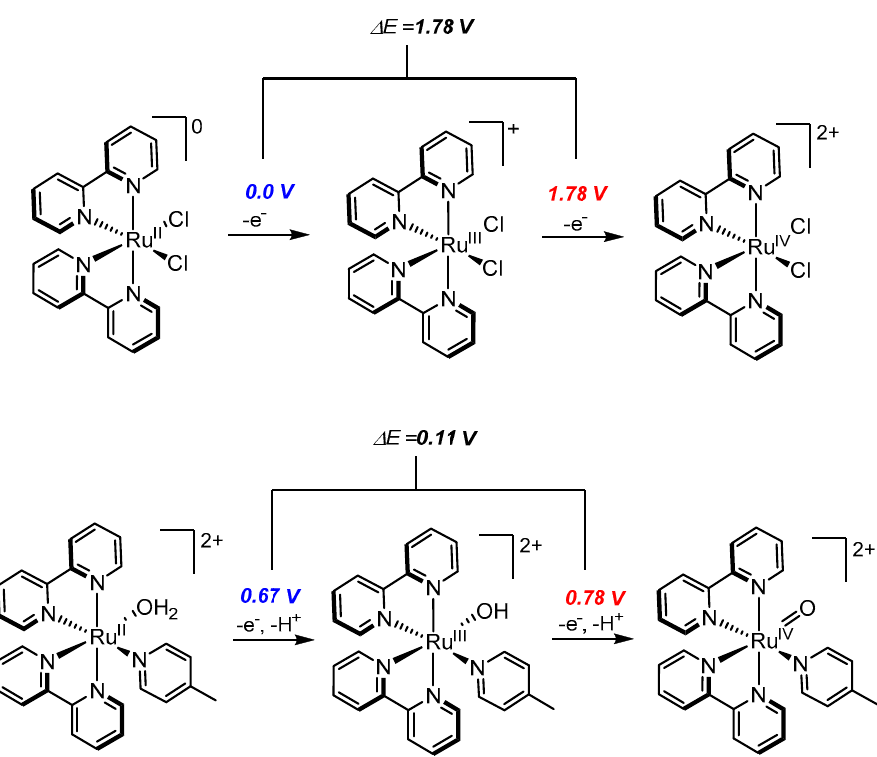
Figure 2. Work done by Meyer showing facile formation of a Ru-oxo intermediate through proton- coupled electron transfer (PCET).